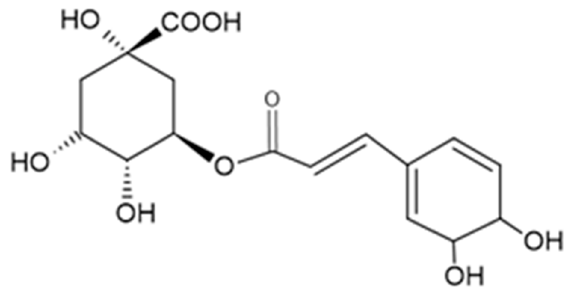
Figure 1. Chemical structure of CGA.